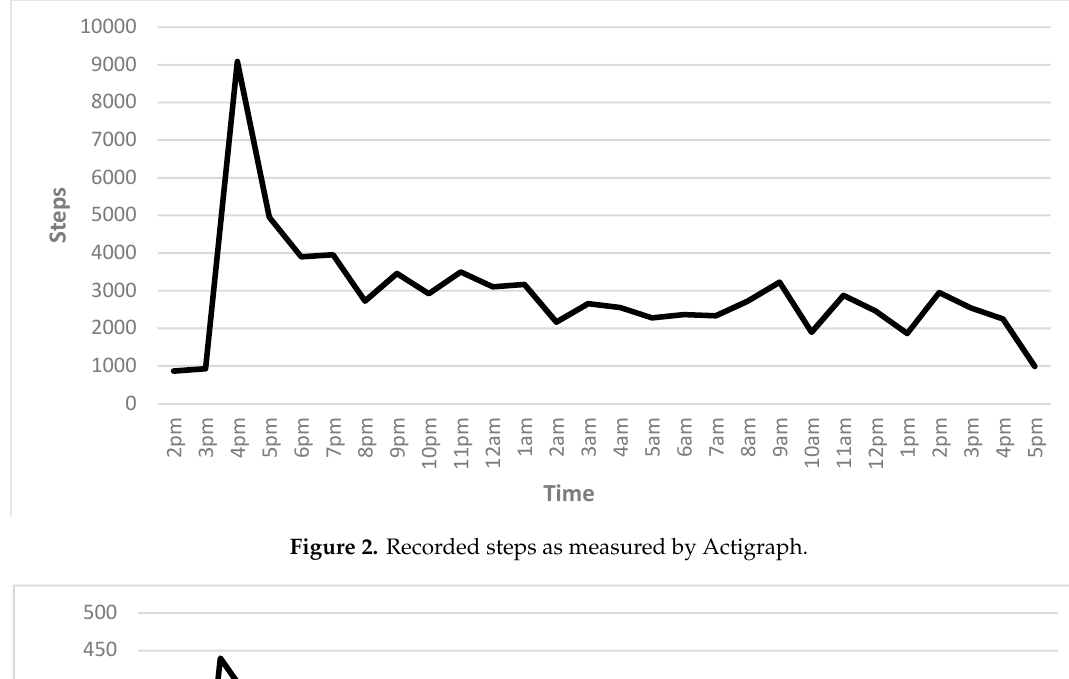
Figure 2. Recorded steps as measured by Actigraph.